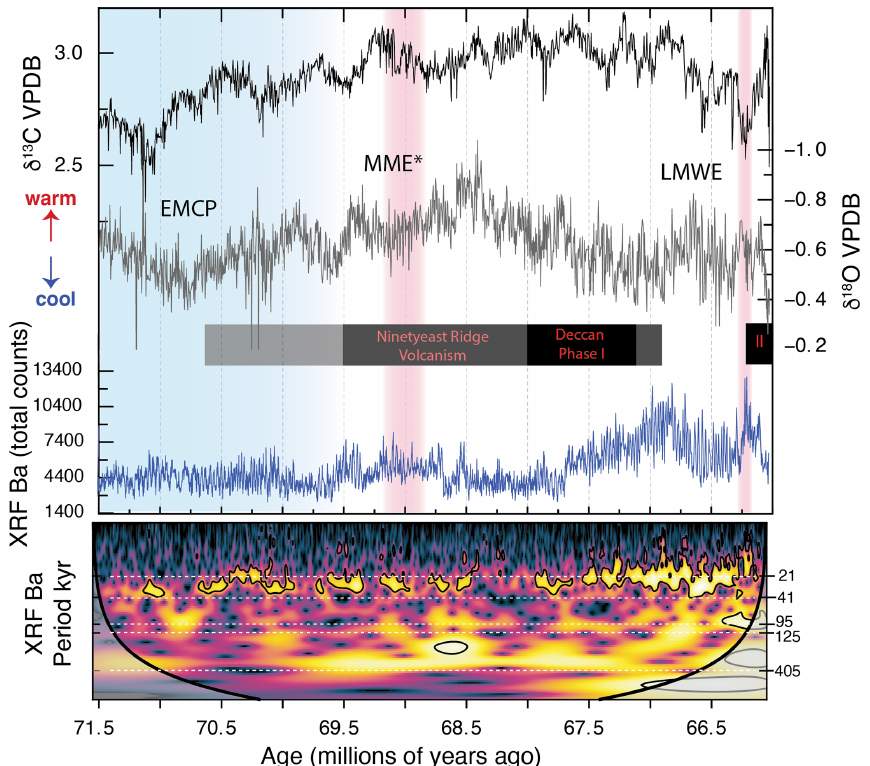
Figure 5. Bulk carbonate δ 13 C, δ 18 O, scanning XRF Ba, and wavelet analysis (Torrence and Compo, 1998; Grinsted et al., 2004) on non- stationary periodicities for XRF Ba (500 LOESS composite of Sites 1209 and 1210) show signals of precession in scanning XRF Ba which strengthen after Deccan volcanism begins. Brighter colors correspond to higher power within a corresponding frequency period (in thousands of years, kyr). Ninetyeast hotspot volcanism and approximate duration of Deccan volcanism shown, adapted from Keller et al. (2016). EMCP: early Maastrichtian cooling pulse (Haynes et al., 2020); MME ∗ : mid-Maastrichtian event beginning at Chron C31n and lasting ∼ 500kyr (Voigt et al., 2012); LMWE: latest Maastrichtian warming event (Li and Keller,